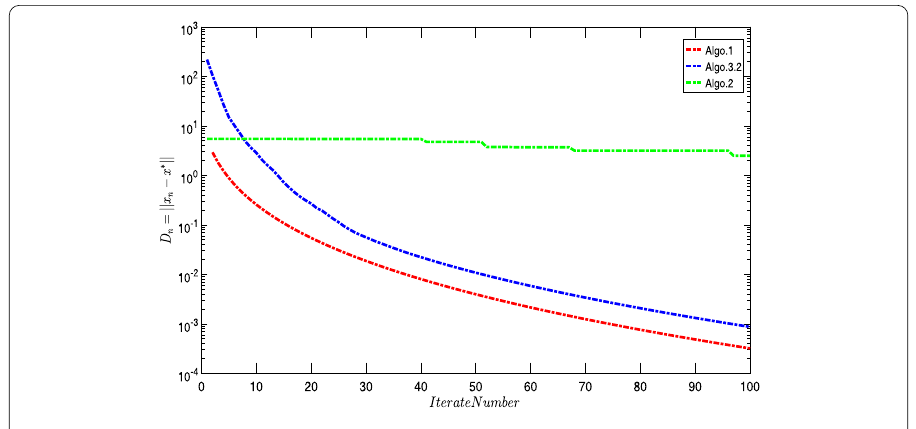
Figure 3 Experiment with m = 30 for Example